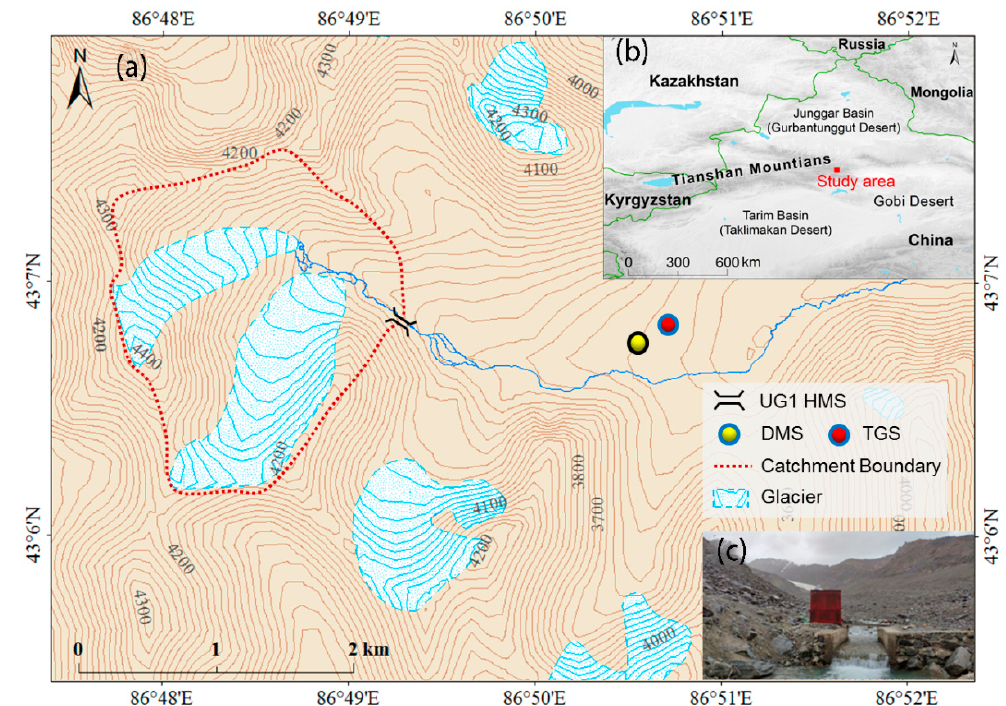
Figure 1. Study site description: ( a ) sketch map of the study catchment including the locations of Urumqi Glacier No. 1 (UG1), Urumqi Glacier No. 1 hydrometeorological station (UG1HMS), Daxigou meteorological station (DMS) and Tianshan Glaciological Station (TGS); ( b ) location of the study site; ( c ) photograph of the Urumqi Glacier No. 1 hydrometeorological station (UG1HMS) (taken by Shuang Jinin, 2018).